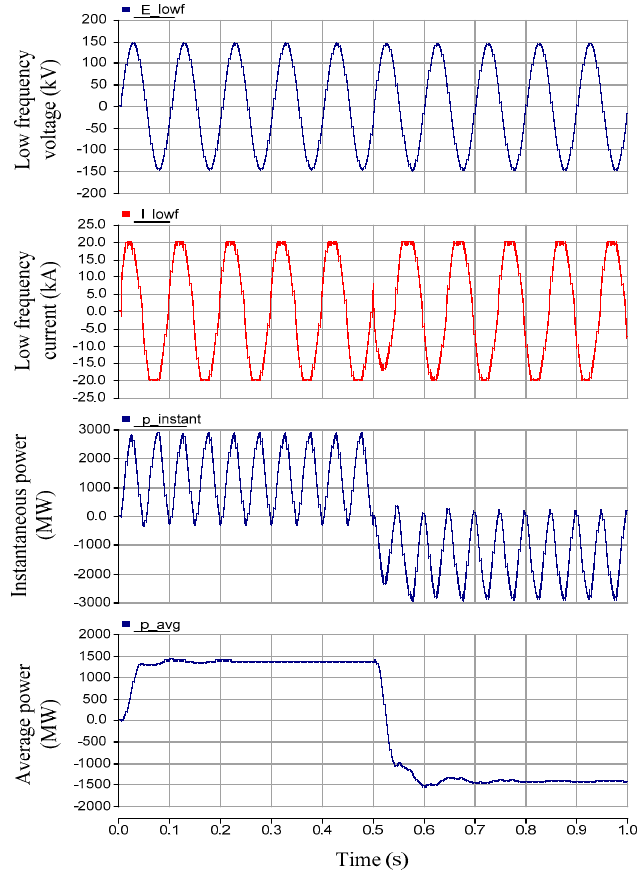
Figure 18. Simulation result for current limiter control.